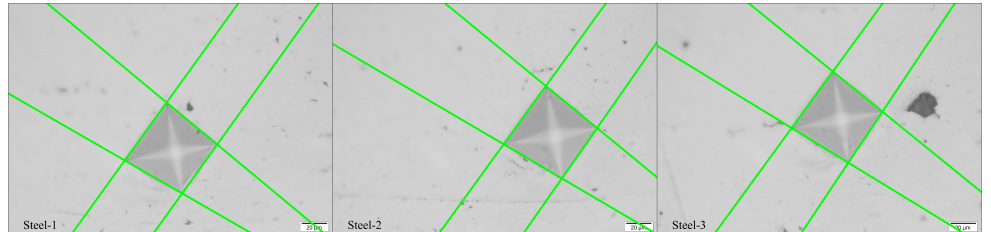
Figure A2. Corner detection on TiNbN samples at 5N applied force.